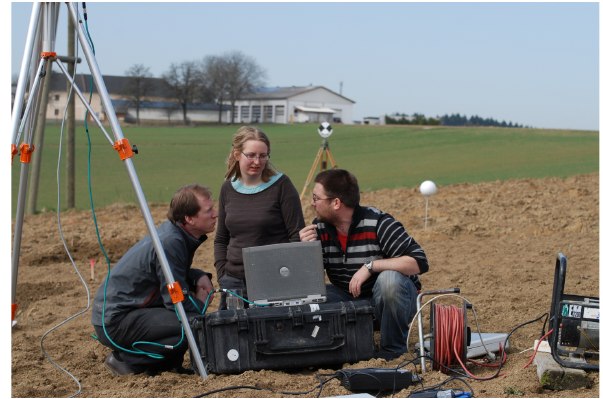
Fig. 6. Field work in the Petzenkirchen Hydrological Open Air Laboratory, a focus catchment located close to